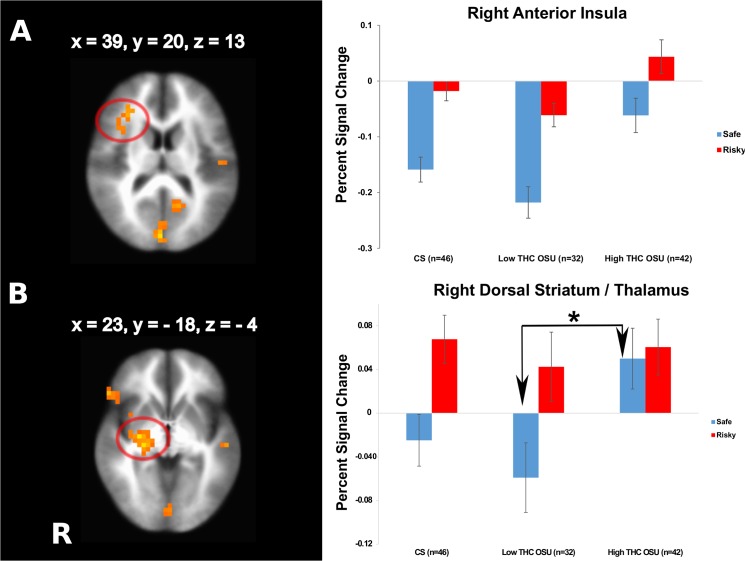
Effects of co-use of marijuana.Occasional stimulant users with relatively high numbers of lifetime co-use of marijuana (High THC OSU) are characterized by (A) a weaker relative deactivation of the right anterior insula to risky and safe decisions (main effect of subgroup,) and (B) a weaker neural differentiation of risky and safe decisions in the dorsal striatum compared to Low THC OSU driven by an absent relative decrease of activation during safe decisions (interaction subgroup by decision), n = 120. Cluster significance of p < .05 corrected for multiple comparisons (voxel-wise probability: p < .05). R indicates right, error bars represent standard errors, asterisk = sign. at p = 0.05.